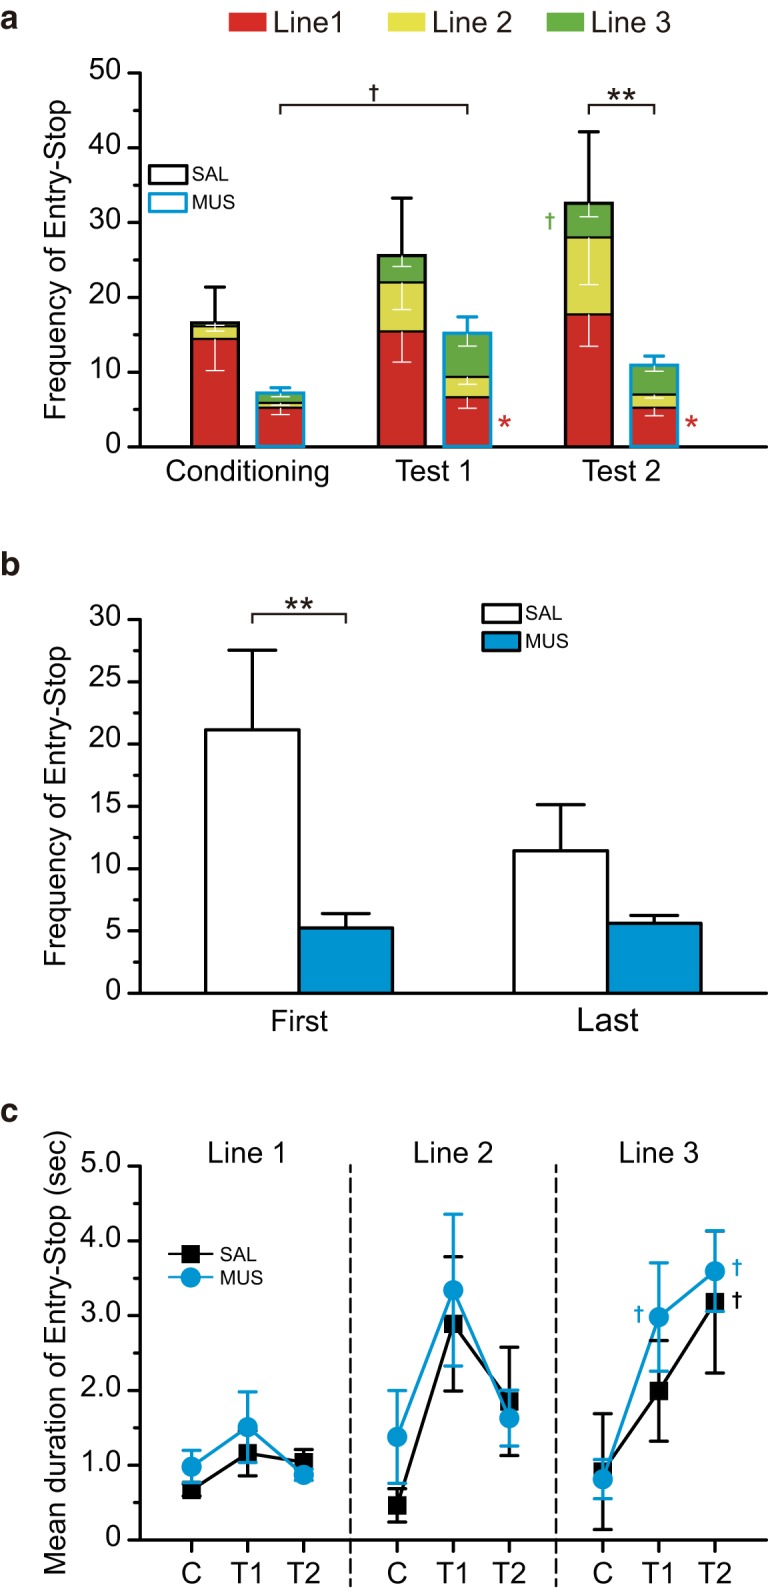
The intra-BLA muscimol decreased the frequency of Entry-Stop. a, The frequency of Entry-Lick in the saline-injected (SAL) or muscimol-injected (MUS) group in Conditioning, Test 1, and Test 2. The CS-US pairings increased entry-stop. On test 2, the MUS group showed significantly smaller stops than the SAL group. b, The frequency of Entry-Stop during the first and last half of Test 2. The muscimol-injected group showed smaller frequency of the stop on both the time windows. There was a significant group difference for the first half. c, Mean duration of Entry-Stop at each line. The CS-US pairings significantly increased mean duration at lines 2 and 3. The mean duration at Line 2 decreased in both groups for Test 2 and increased at Line 3 for Test 2. However, there were no differences between the groups. C, Conditioning; T1, Test 1; T2, Test 2; **p < 0.01, *p < 0.05 (vs SAL), †p < 0.01 (vs Conditioning).